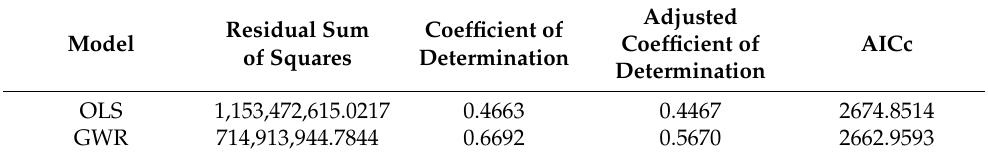
Table 4. Comparison of fitting results between OLS and